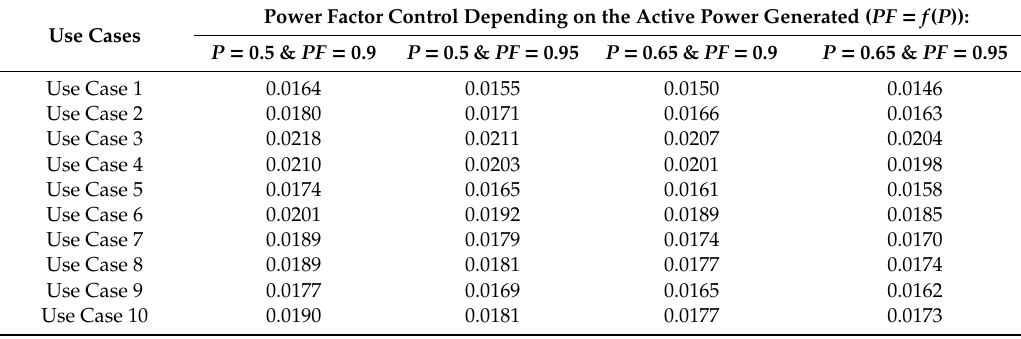
Table A7. Power factor control depending on the active power generated: Losses.